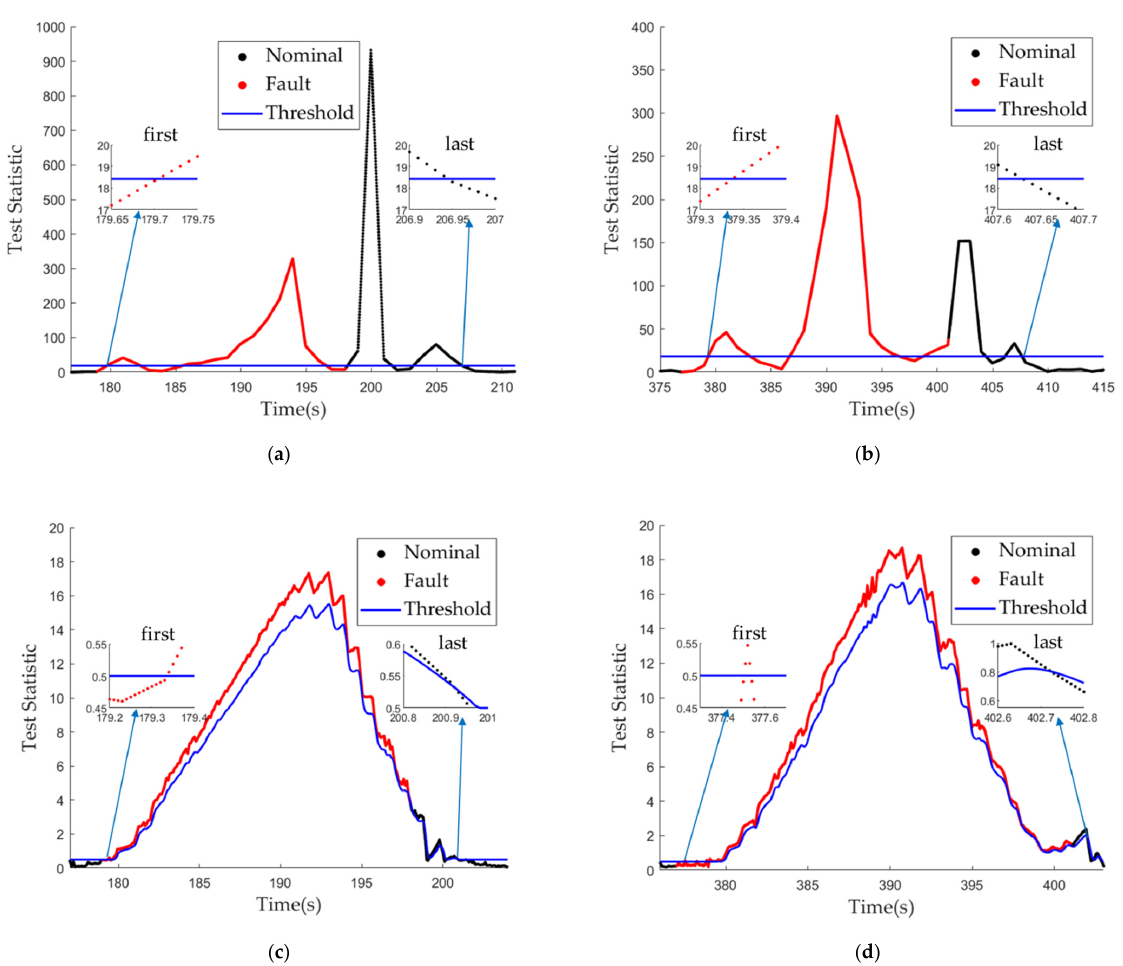
Figure 24. Local magnifications of Figure 23 for the fault detection algorithm. ( a ) The first fault detected by the residual chi-square test. ( b ) The second fault detected by the residual chi-square test. ( c ) The first fault detected by the LiDAR aided fault detection algorithm. ( d ) The second fault detected by the LiDAR aided fault detection algorithm. Table 6. The fault detection performance of the residual chi-square test and the proposed algorithm. The Residual Chi-Square Test